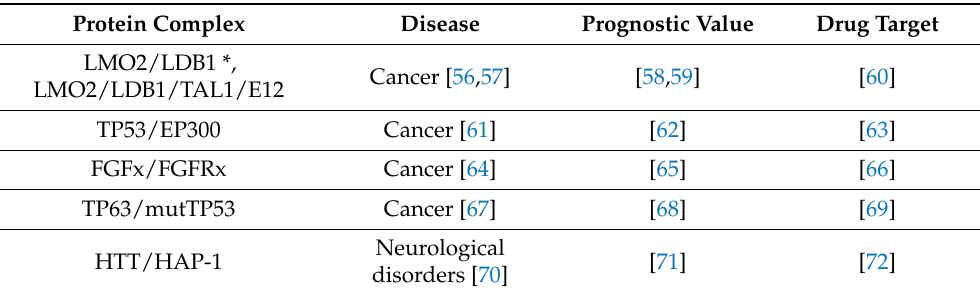
Table 3. Examples of disease-related PPIs. Protein Complex